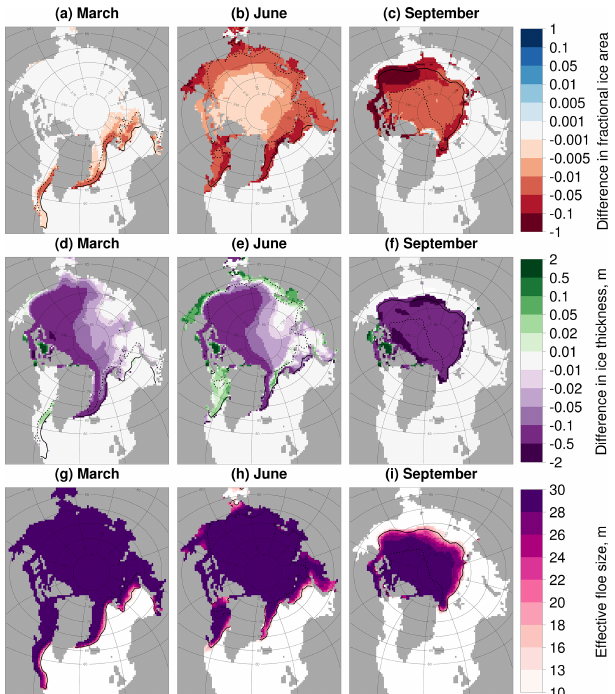
Figure 8. As Fig. 6 except now the difference between (A) com- pared to stan-fsd is given, i.e. the impact of changing α from 2.5 to 3.5 with the other FSD parameters held at standard values. l eff is reported for the simulation with the higher magnitude α . In general, the plots show a reduction in the sea ice concentration and ice thick- ness across the sea ice cover. This corresponds to the behaviour of the l eff , with the l eff 30m or below across the sea ice cover. Figure 9. Relative change (%) in mean September sea ice extent (a)